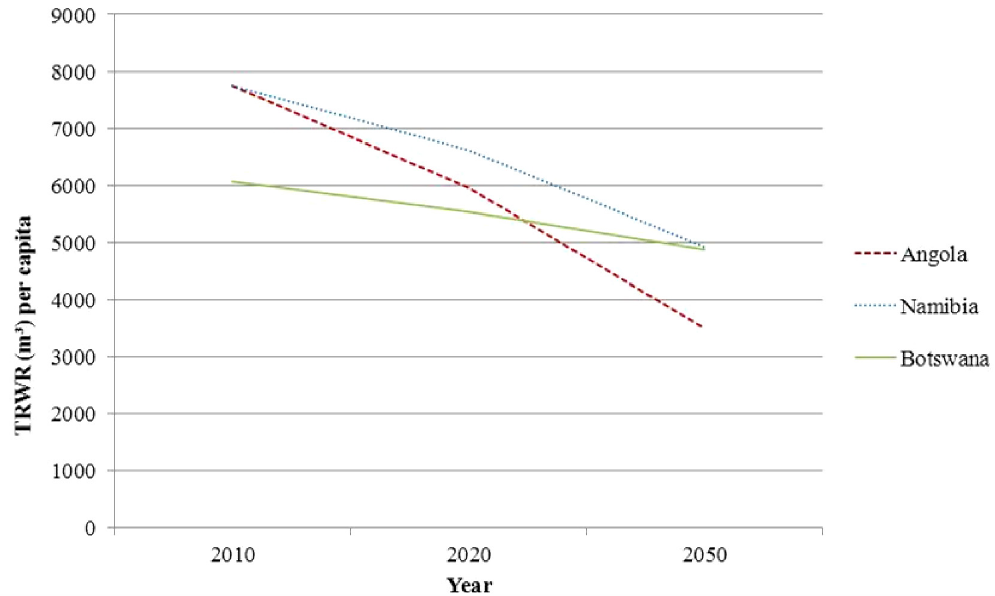
Figure 4. Projected total renewable water resources (TRWR) per capita for 2010, 2020 and 2050 in Angola, Botswana and Namibia (own representation based on data from [24–27]).